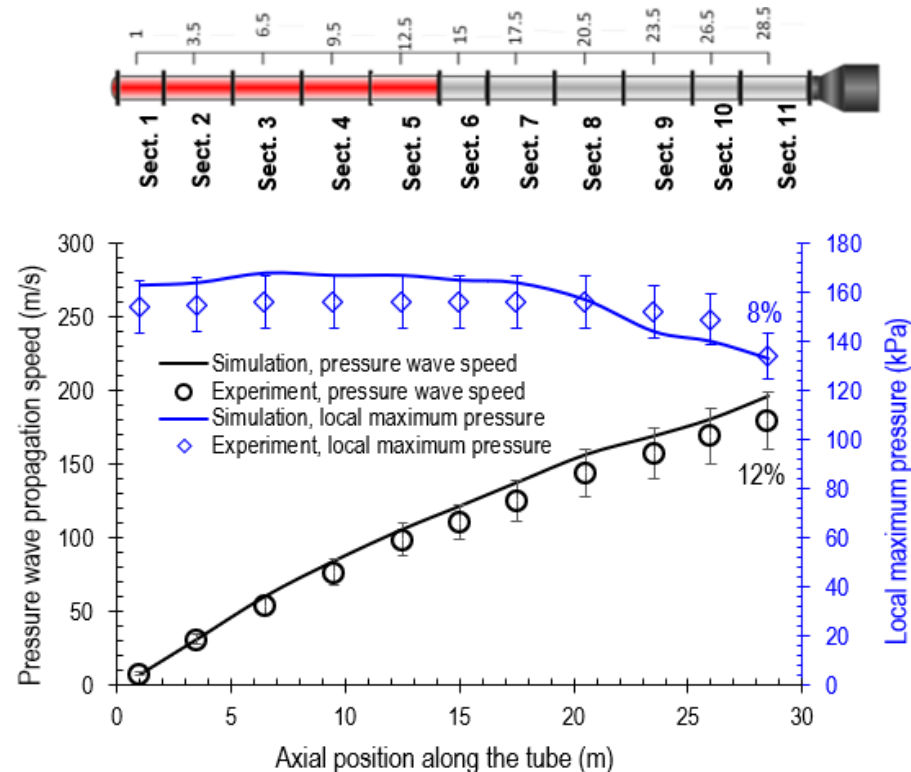
Figure 4. Comparisons on pressure wave propagation speed and flame propagation speed at different axial positions along the tube. Sections coloured in red are reactive regions (CH 4 % = 9.5% in Sections 1–5) and sections coloured in grey are non-reactive regions (CH 4 % = 0 in Sections 6–11). Ignition is achieved using a 50 mJ chemical ignitor in Section 1 at 0.195 m from the start of the